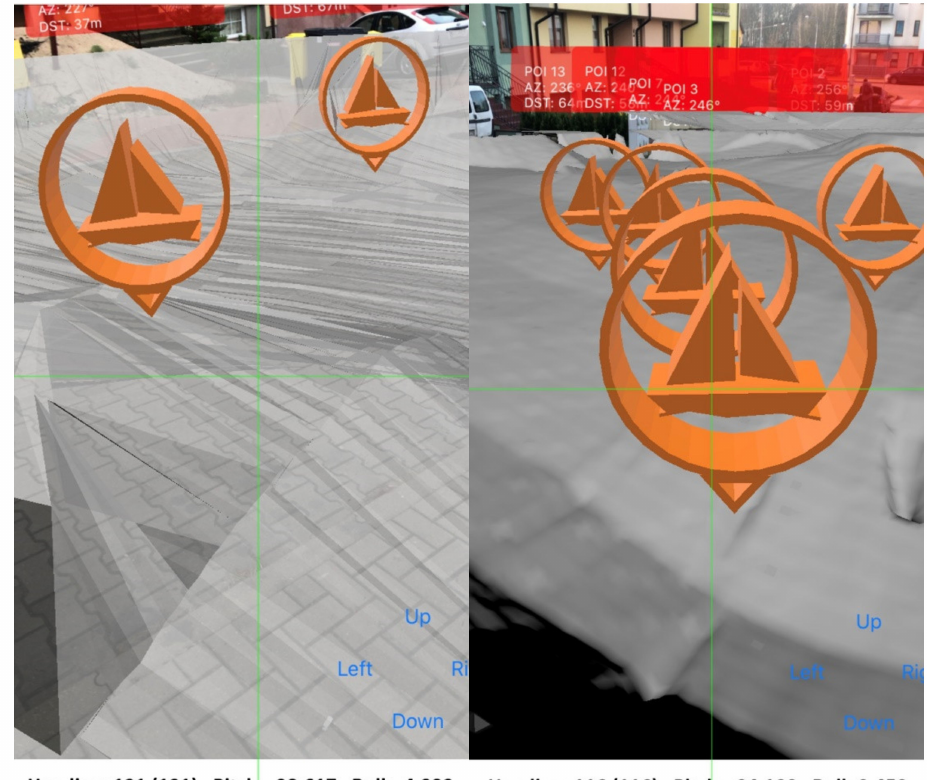
Figure 14. Examples of Augmented Reality applied to the navigation process—data fusion of the virtual location of sailors and Digital Elevation Model of the bottom of the water